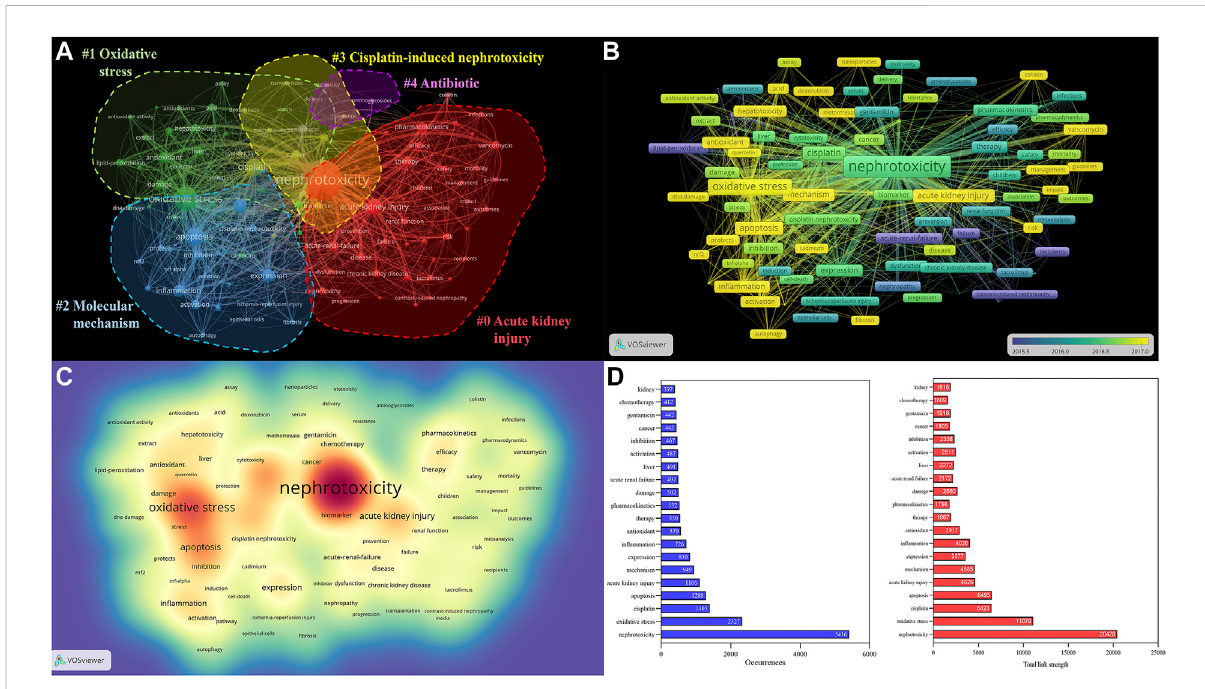
FIGURE 6 Analysis of all keywords in studies related to nephrotoxicity research. (A) VOSviewer visualization map of co-occurring keywords. Of the 23,900keywords,120hadatleast100co-occurrences. (B)